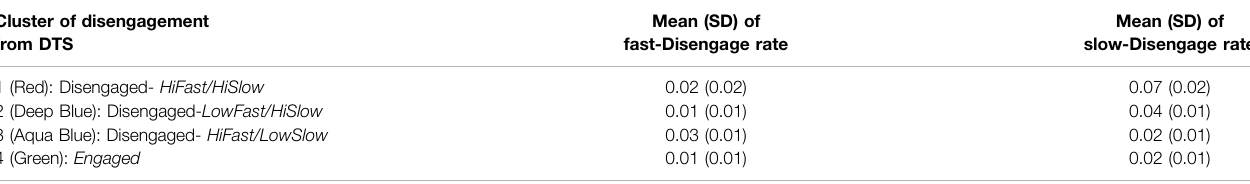
Mean (SD) of fast-Disengage rate